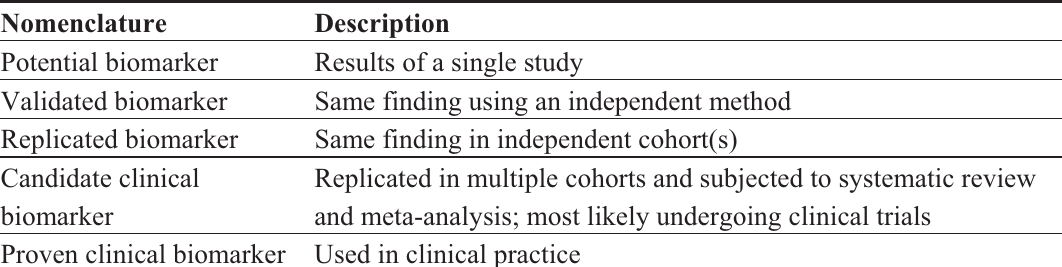
Table 1. Nomenclature used in this review for the stages of DNA methylation biomarker